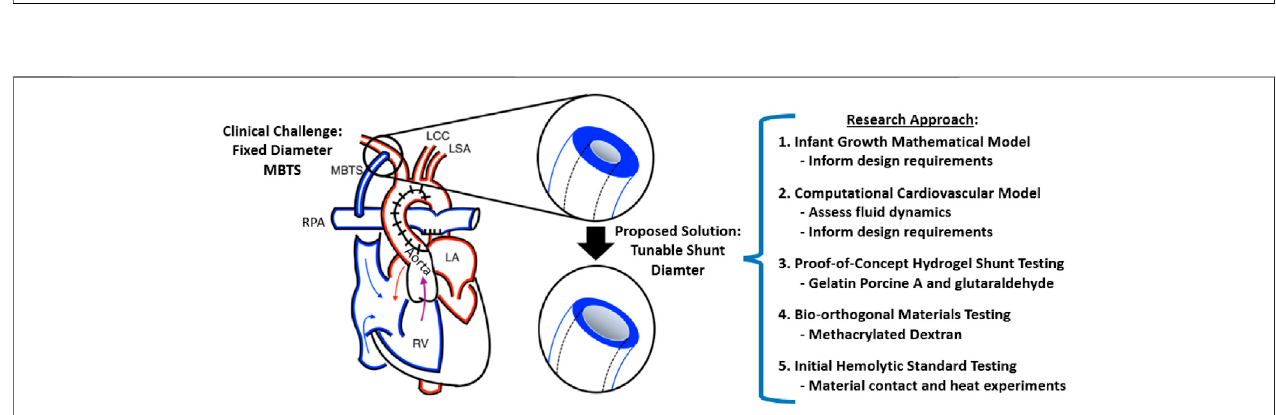
FIGURE 2 | Overview of the Study. The Modi fi ed Blalock-Taussig shunt (MBTS) implanted in a single ventricle heart connects the systemic and pulmonary circulations,withtherelevantanatomyincludingtherightpulmonaryartery(RPA),rightventricle(RV),leftventricle(LV),leftatrium(LA),leftcommoncarotid(LCC),andleft subclavian (LSA). We developed an infant growth mathematical model and computational cardiovascular model, which both informed the design requirements for the proof-of-concept hydrogel prototype testing and then bio-orthogonal prototype testing with initial hemolytic standard experiments.